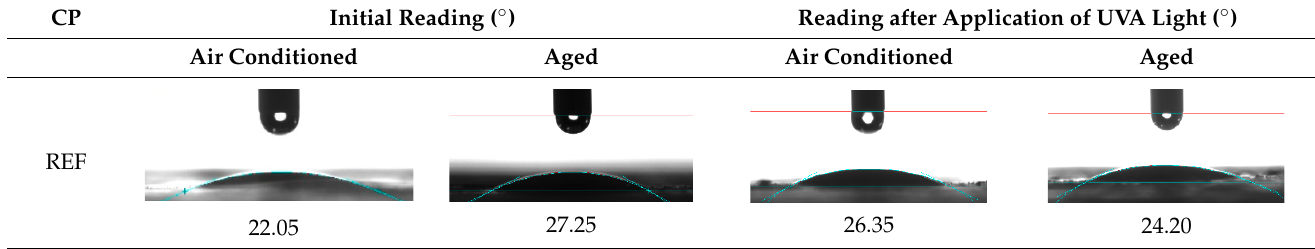
Table 10. Contact angle of a water drop on the surface of a cement tile, before and after application of UVA light, under air conditioned curing and accelerated aging.